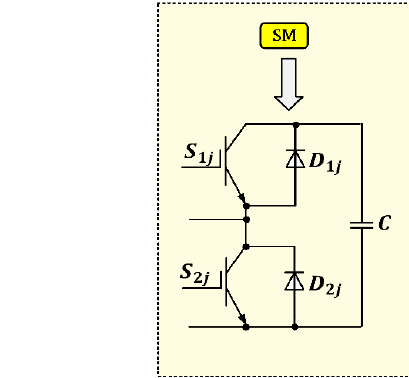
Figure 9. Hybrid Cascaded DC-DC Converter (HCDC) circuit diagram.